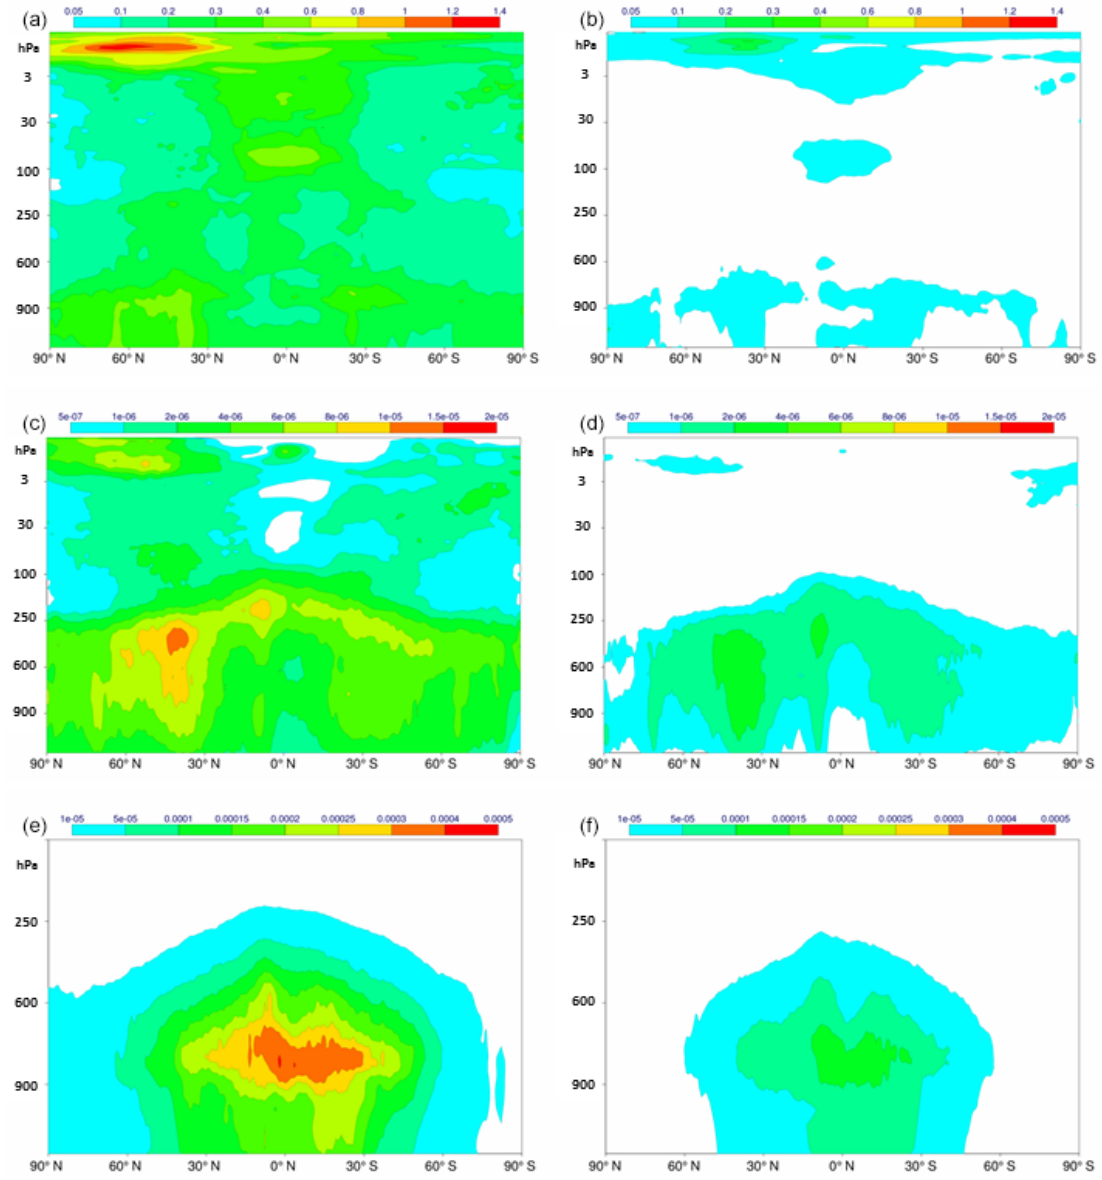
Figure 7. Vertical profiles of the longitudinally averaged standard deviation of the analysis increments produced at the end of the first outer loop minimisation (a, c, e) and the fifth outer loop minimisation (b, d, f) for temperature (a, b) , vorticity (c, d) and humidity (e, f) . Details of the assimilation experiments as described in